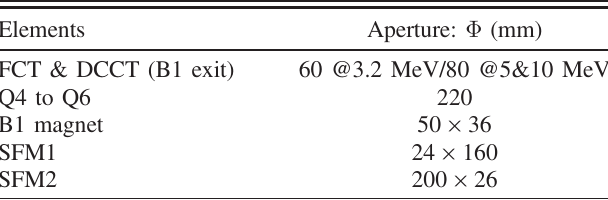
TABLE VI. Major optics aperture along the beam dump line.